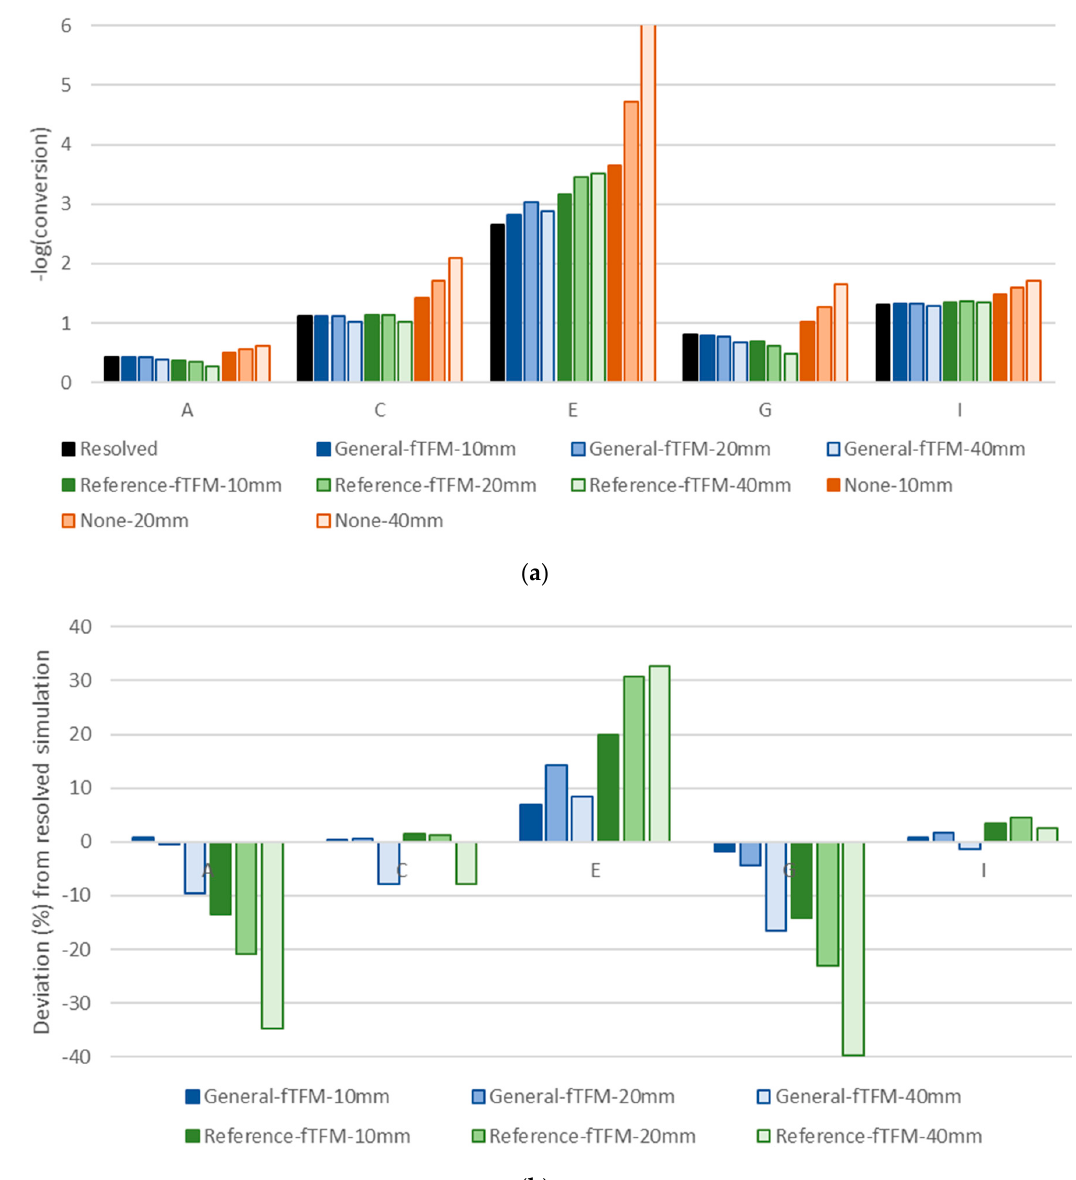
Figure A2. Evaluation of different approaches to modeling the filtered reaction rate in coarse-grid simulations of fast bubbling flow: neglecting subgrid effects on the filtered reaction rate (None), using an effectiveness factor for a reference first-order reaction (Reference), and using the generalized effectiveness factor closure described in this paper (General). Three different grid sizes were considered in the coarse-grid simulations. ( a ) Comparison of the scaled conversion for the different cases; ( b ) comparison of the percentage error of the generalized and reference closure predictions when compared to the benchmark resolved simulations.